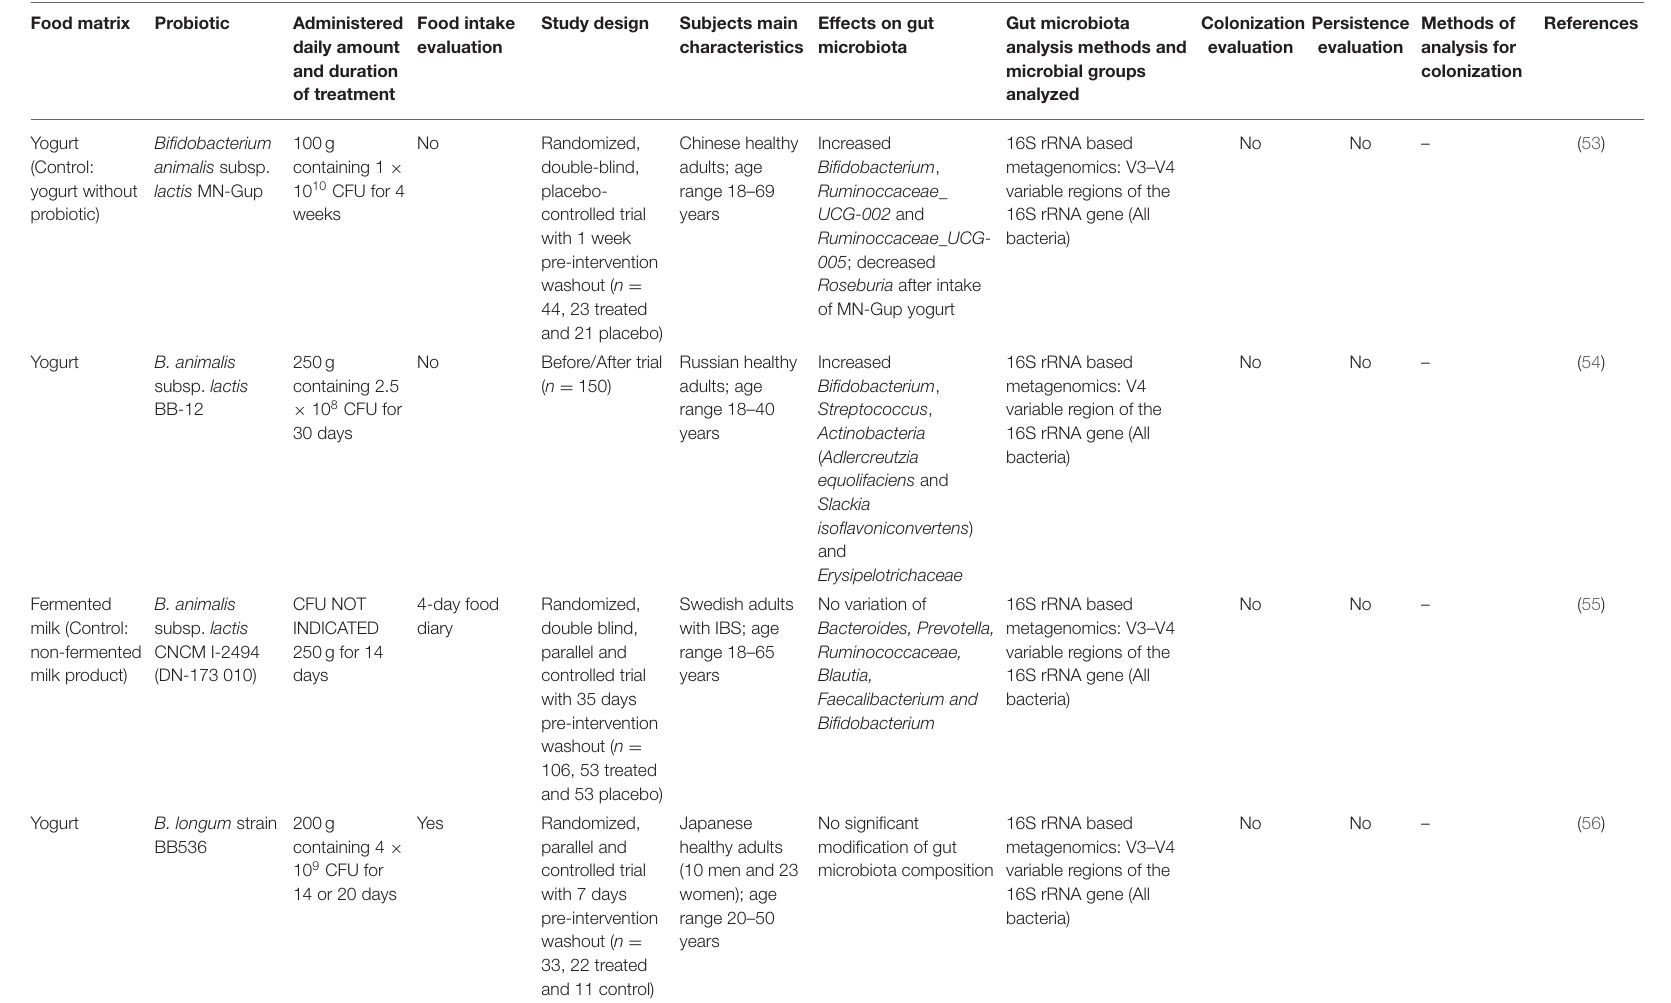
TABLE 5 | Human intervention studies using fermented foods containing probiotic Bifidobacterium strains. Food matrix